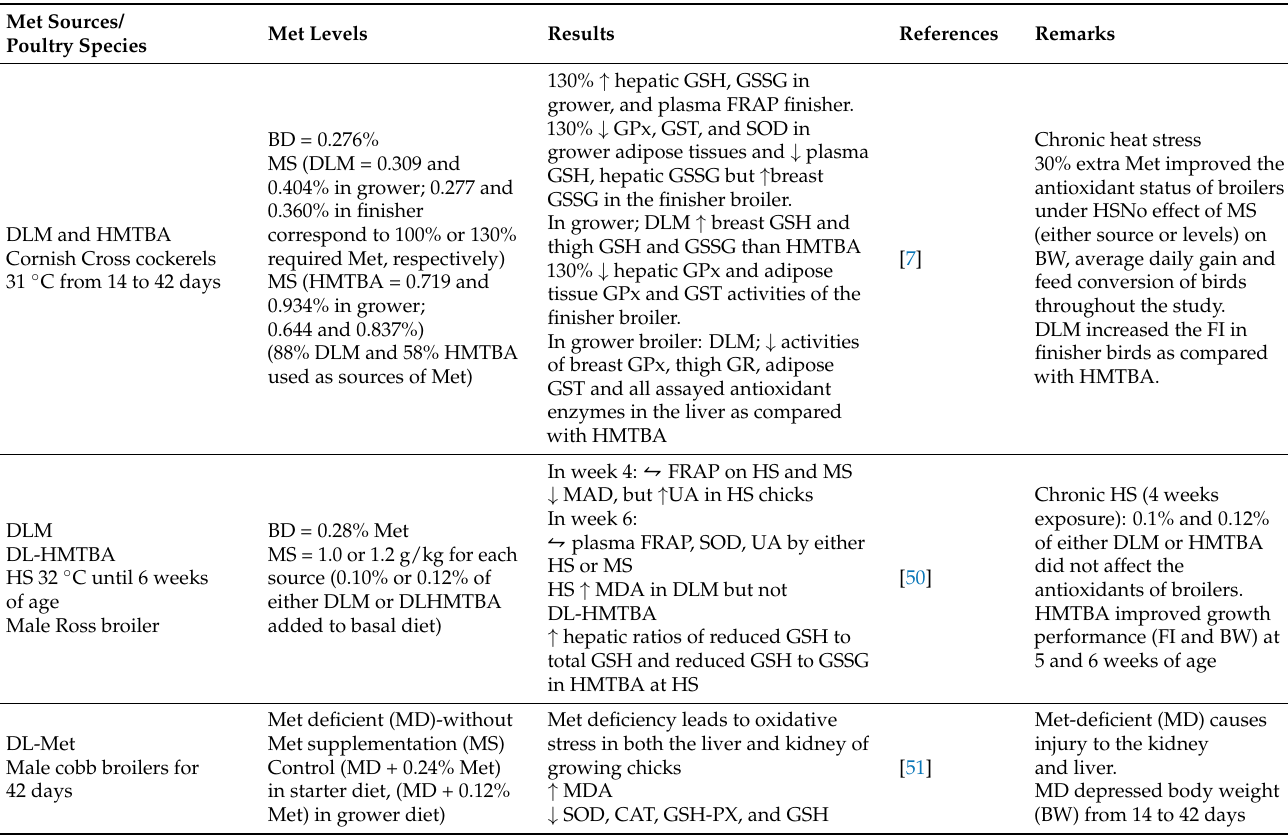
Table 1. The effects of dietary Met supplement (in ovo, diet, water) on the oxidative stress on poultry under heat stress and cold stress